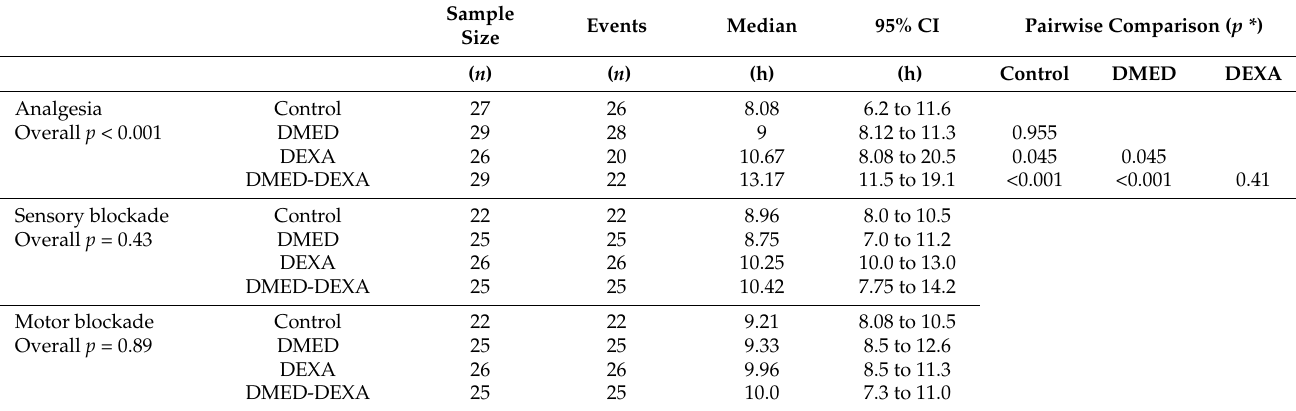
Table A1. Survival analysis for the duration of analgesia and sensory and motor blockade. * Adjusted using the Benjamini and Hochberg method. Events were patients requiring analgesia and reporting sensory and motor recovery in each outcome.